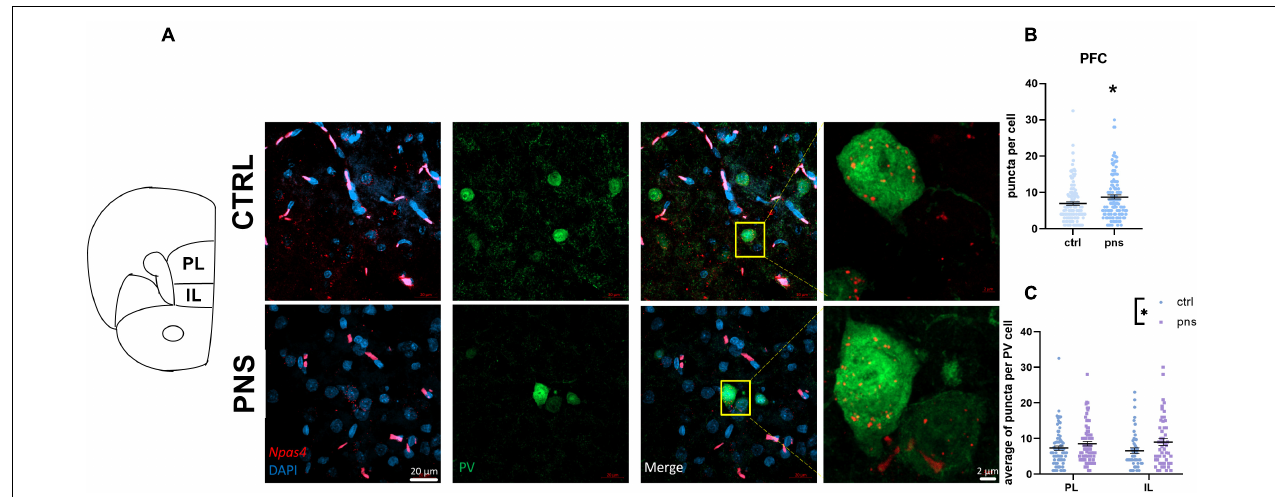
FIGURE 5 | ( A ) Left: Schematic of adult rat bregma locations of prefrontal cortex subregions included in our analysis to selectively target the expression of Npas4 in PV neurons. PL, prelimbic cortex; IL, infralimbic cortex. Right: Representative images from multiplexed RNA scope experiment aimed at detecting Npas4 (red) expression in the parvalbumin-positive neurons (green) of the prefrontal cortex (PFC). Inset shows magnified portions depicted by the yellow box. ( B ) Quantification of Npas4 expression across the PFC, n = 124–134 cells (data from 4–6 rats per group). Symbols represent individual data, * p < 0.05 (Student’s t -test). ( C ) Quantification of Npas4 expression in PL, n = 72–81 cells, and IL, n = 49–52 cells (data from 4–6 rats per group). Symbols represent individual data, * p < 0.05 (two-way ANOVA).